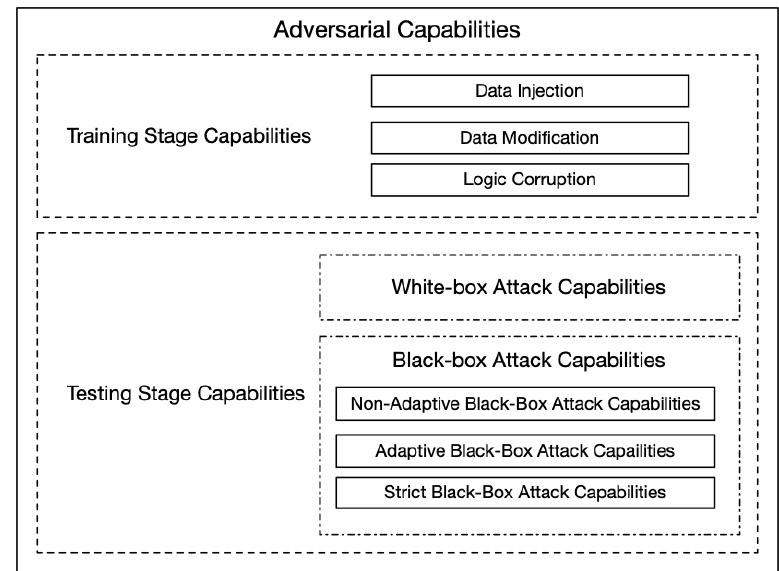
Figure 3. The classification of adversarial